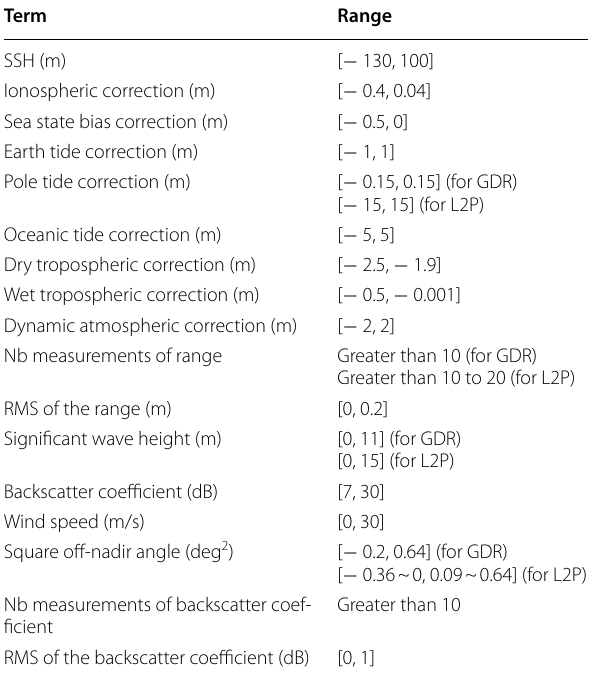
Table 1 Editing criteria of altimeter